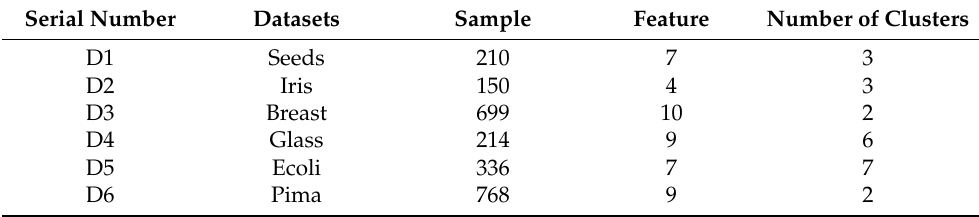
( e ) C9 dataset Figure 4. Clustering results of PRI-MFC algorithm on artificial datasets. It can be seen from the figure that the clustering effect of K-means on the tricyclic datasets, bimonthly datasets, and spiral datasets with uniform density distribution is not ideal. However, K-means has a good clustering effect on both C5 datasets and C9 datasets with uneven density distribution. The PRI-MFC algorithm has a good clustering effect on the three-ring datasets, bimonthly datasets, spiral datasets, and C9 datasets. While accurately clustering the data, it more accurately marks the outliers in the data. However, it fails to distinguish adjacent clusters on the C5 datasets, and the clustering effect is poor for clusters with insignificant clusters in the data. Comparing the clustering results of the two algorithms, it can be seen that the clustering effect of the PRI-MFC algorithm is better than that of the K-means algorithm on most of the experimental datasets. The PRI-MFC algorithm is not only effective on datasets with uniform density distributions but also has better clustering effects on datasets with large differences in density distributions. 5.3.2. Experiments on UCI Datasets In this section, experiments on PRI-MFC, K-means [1], ISODATA [59], DBSCAN, and KMM [1] are carried out on various UCI datasets to verify the superiority of the PRI-MFC from the perspective of clustering quality, time, and algorithm parameter influence.